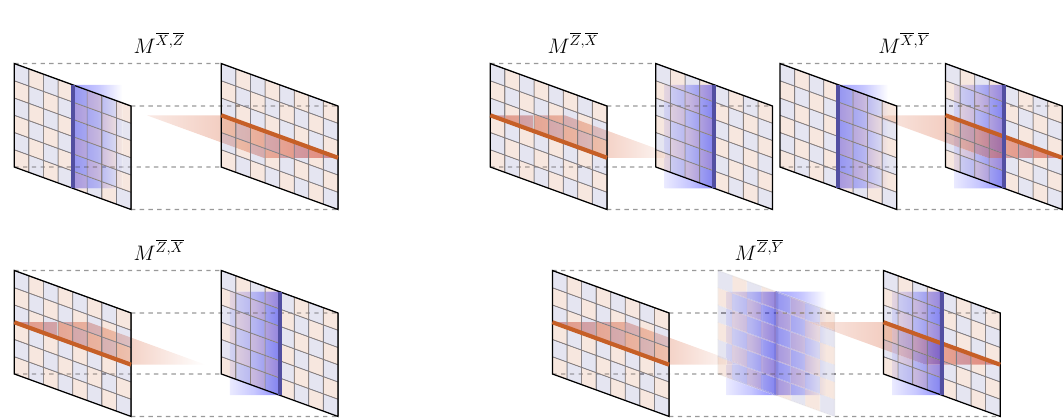
FIG. 3. Schematic representation of ports, logical correlators (membranes) for surface code computations. The internal structure for the fault-tolerant quantum instrument is omitted, leaving only the ports depicted, with the input (output) being on the left (right) of each instrument. Left: correlator representation of the logical Hadamard. The first (second) tensor factor corresponds to the input (output) of the instrument. A fault-tolerant instrument realizing this operation has logical membranes for each stabilizer in S ( H ) , which can be understood as mapping logical observables between input and output ports. Right: fault-tolerant instruments can be composed along a pair of input and output ports that share a common code, leading to new composite logical